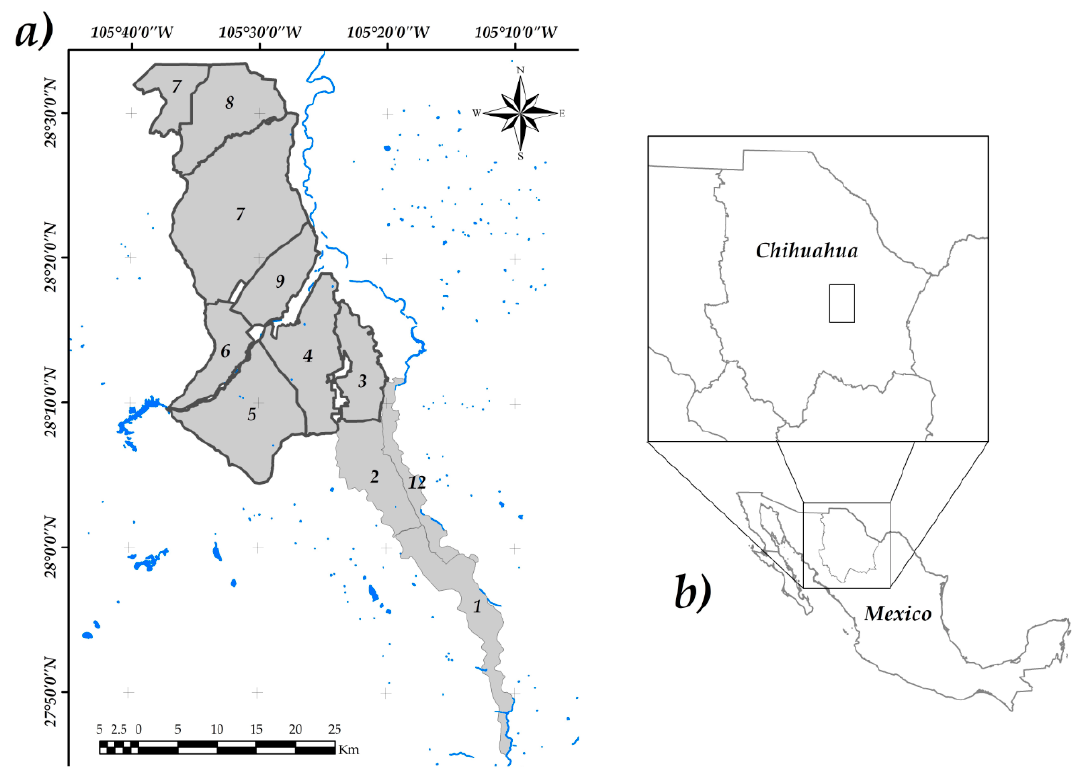
Figure 1. Geographical location of the study area: ( a ) Irrigation District 005 location ( ■ ), boundary of the studied area ( — ), water bodies ( — ), bold numbers denote the module number, ( b ) Irrigation District 005 location in Chihuahua, Mexico.